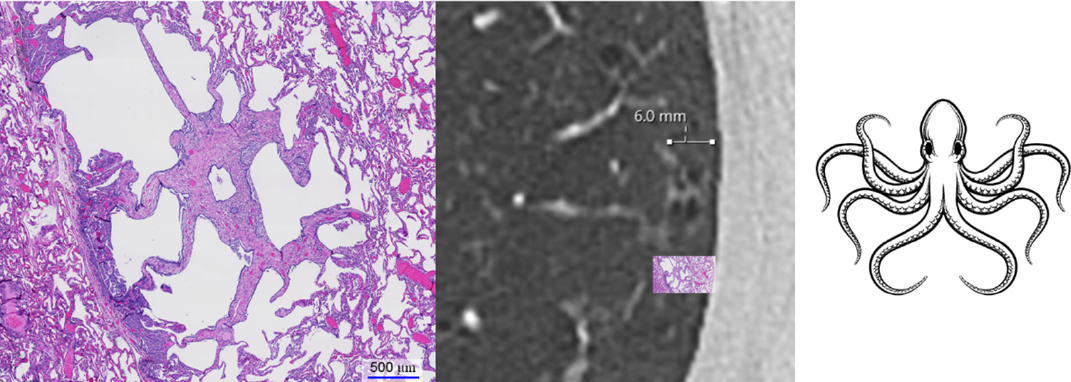
Figure 1. Correlation of the “octopus sign” on histology and HRCT. The histological specimen shows a fibrotic Langerhans cell histiocytosis lesion with a central, peribronchiolar fibrosis extending into the periphery, resulting in architectural distortion with traction emphysema (hematoxylin and eosin staining). The septal extensions of the lesion resemble tentacles of an octopus. The HRCT of the same patient also showed lesions that were similar in shape to an octopus.